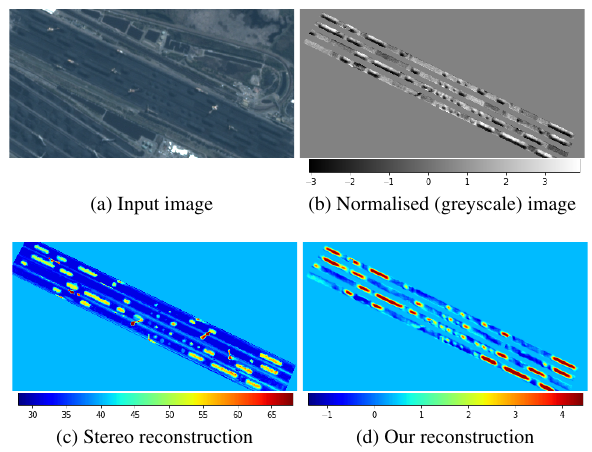
Figure 1. Stockpile monitoring with Shape-from-Shading. (a) shows the input PlanetScope image (3m pixel resolution), (b) the ROI after normalisation, (c) stereo reconstruction from SkySat imagery (0.8m resolution) and (d) output of the proposed method using